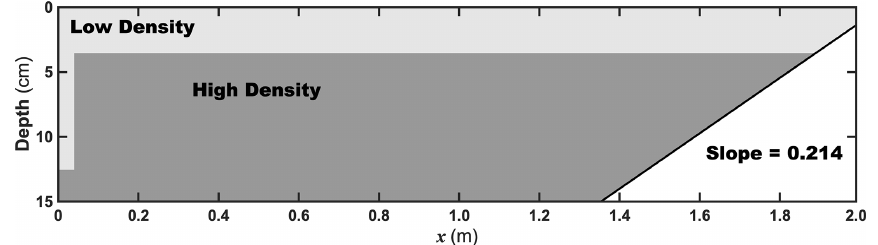
Figure 13. As in Fig. 4, the low and high densities are set to 1000.01 and 1047.00kgm − 3 with a linear slope terrain placed in the east of the tank; for the related configuration, refer to Bourgault and Kelley